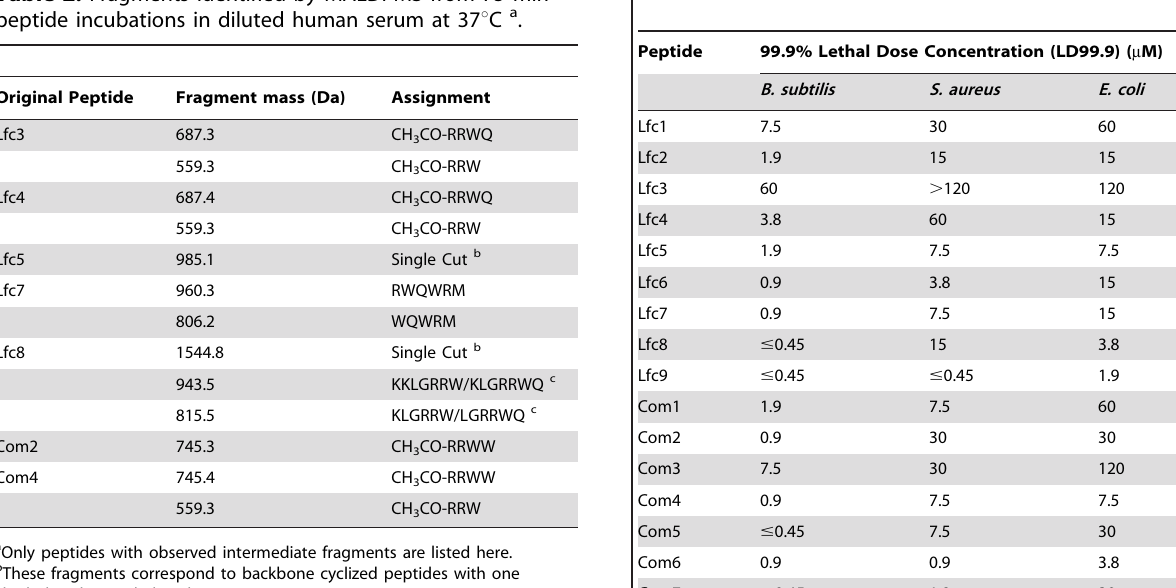
Table 3. Antimicrobial activities of the short LfcinB and Combi